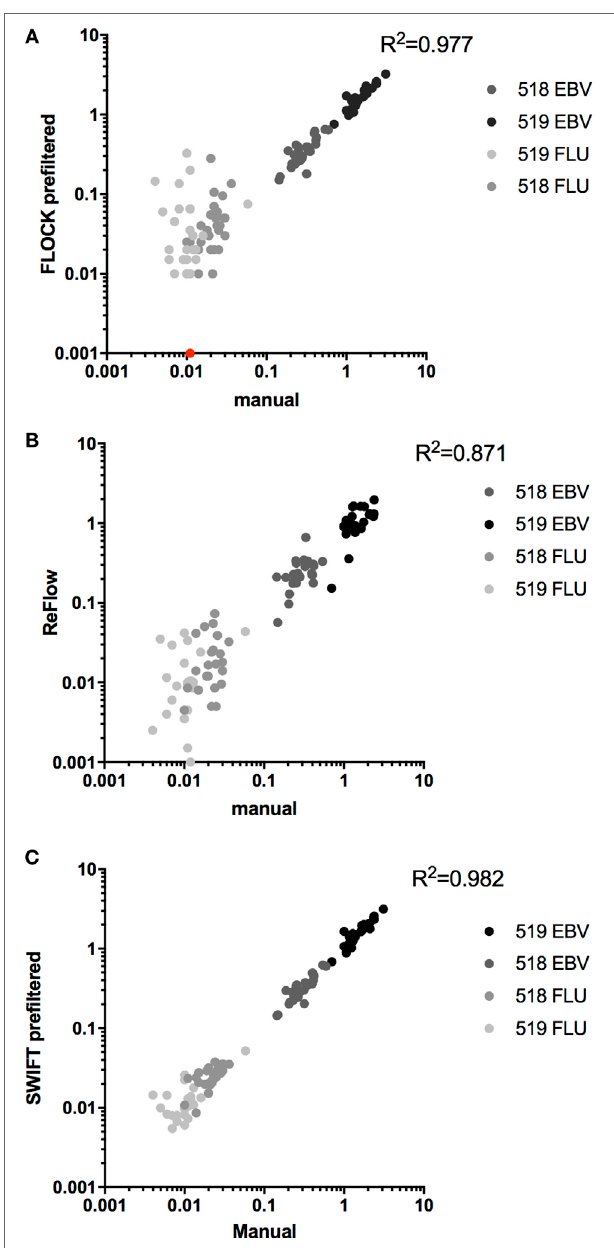
FigUre 3 | Automated analyses versus central manual gating. Correlation between automated analyses and central manual gating for the identification of MHC multimer positive T cell populations, using either of the three algorithms: (a) FLOCK, n = 112, p < 0.0001, one data point of 0% was converted to fit the log axis (given in red); (B) ReFlow, n = 92, p < 0.0001; (c) SWIFT, n = 108, p < 0.0001. All p -values are Pearson’s correlations. Different colors indicate different